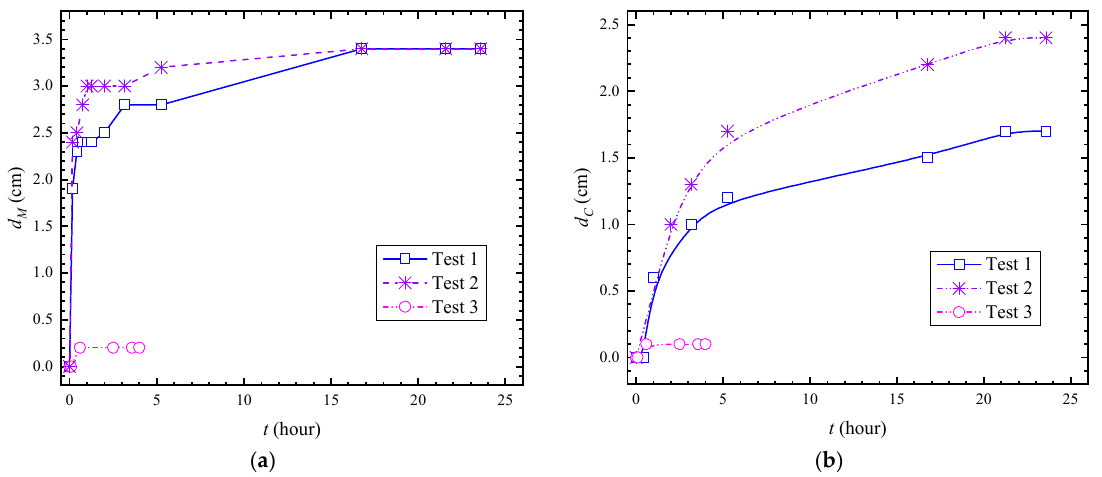
Figure 3. Key points’ scour depths evolutions over time. ( a ) Upstream corner scour depth evolution; ( b ) Center of upstream scour depth evolution.